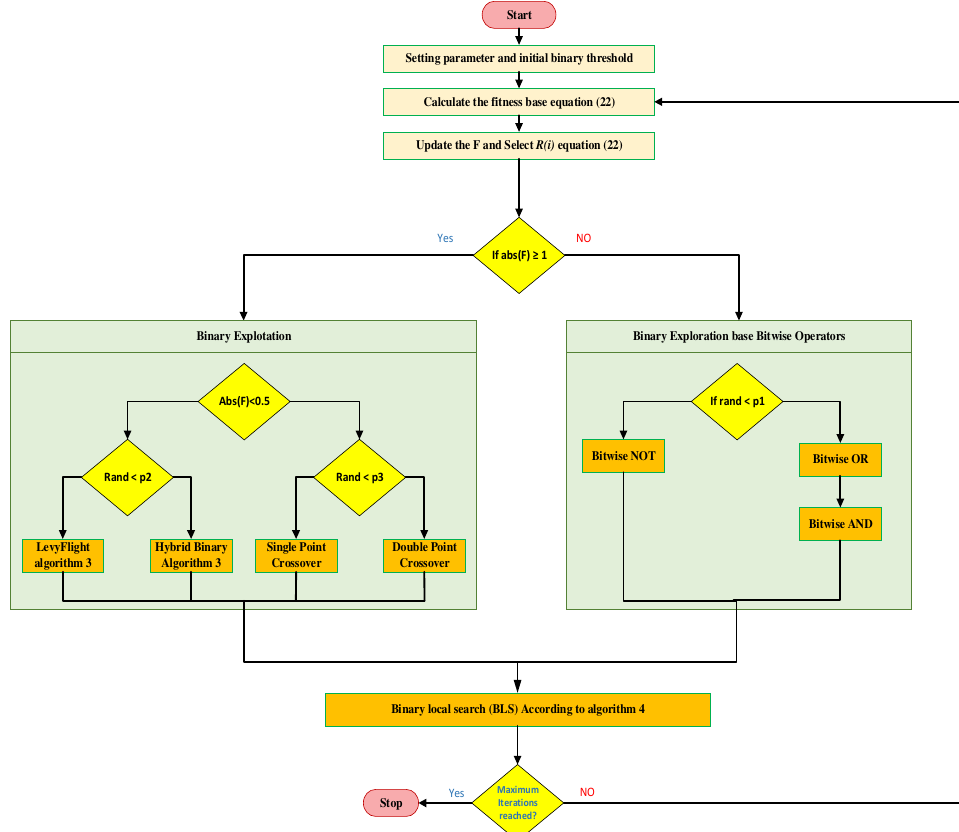
Figure 6. Flowchart of the proposed BAVOA-v1